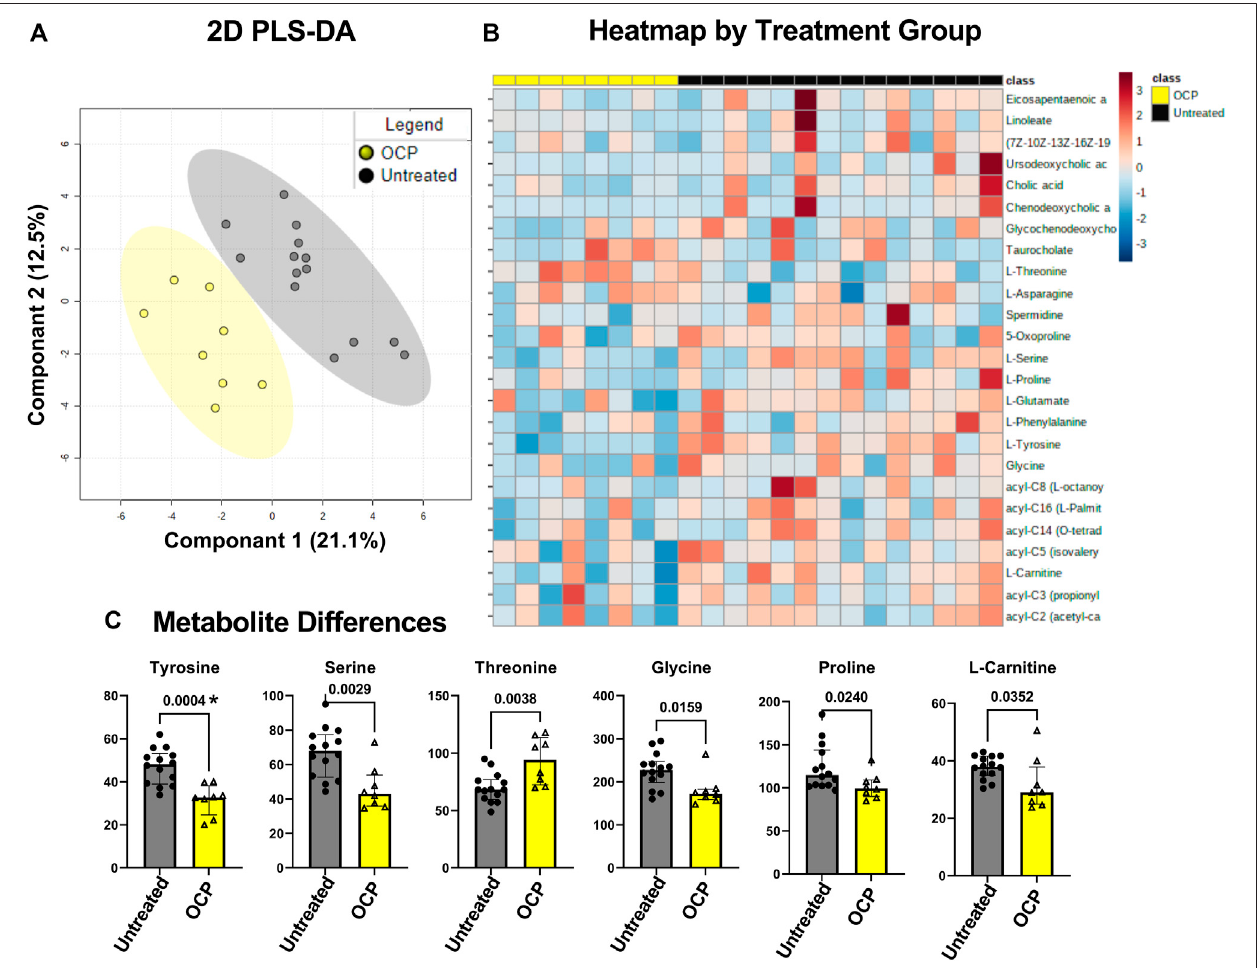
FIGURE 3 | Partial least-square discriminant analysis (PLS-DA) of target Metabolomics by group. (A) PLS-DA of targeted metabolomics including free fatty acids, bileacids,andbranchedchainaminoacidswasdifferentbetweengroups,PLS-DAshoweddiscriminationbetweenthetwogroupsacrossprincipalcomponent1,which explained 21.1% of the total metabolic variance across samples (B) Heatmap of top 25 metabolites (C) 6 serum metabolites were different between the groups with unadjusted p -value.OnlyTyrosine marked *,remained sowithFalseDiscoveryRateadjustmentformultiple comparisons.Girlswithobesityand PCOS with(N =8) and without (N = 14) oral contraceptive treatment were